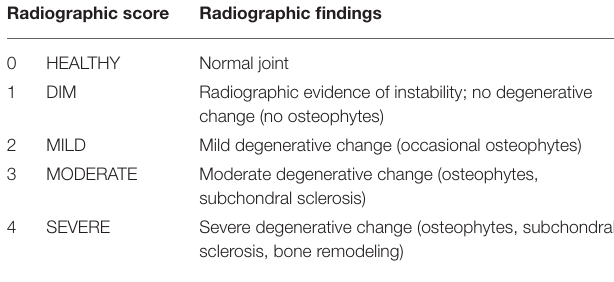
TABLE 1 | Grading of radiographic findings based on blinded evaluation of